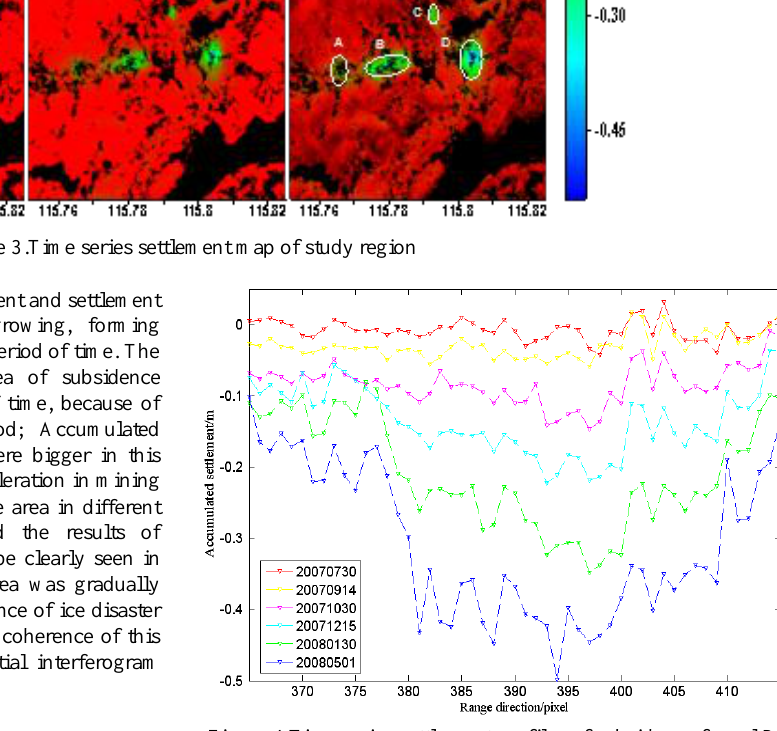
Figure 4.Time series settlement profiles of subsidence funnel D in Range direction